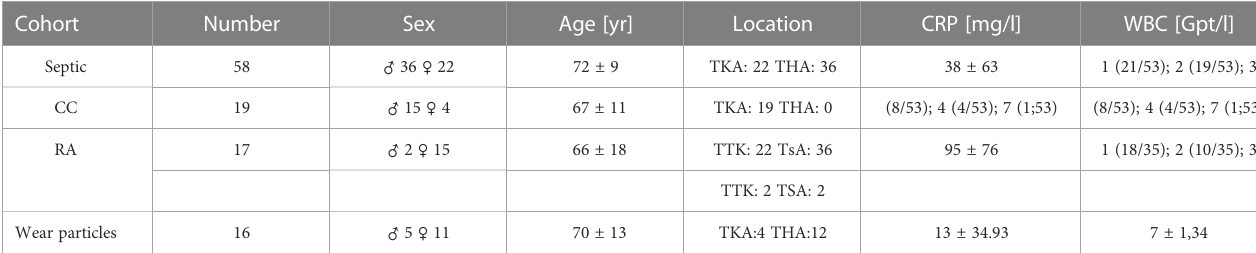
TABLE 3 Patient characteristics of septic, CC, RA and wear particles cohort.